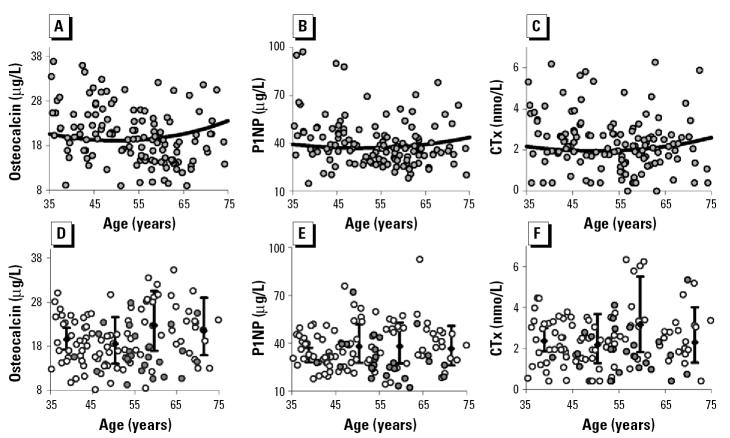
Background levels of the markers of bone turnover in men (A–C) and women (D–F). The lines represent the estimates from the robust regression models described in the text. In A–C, curvature lines and p-values represent the estimates of squared age variable. All p-values for associations between the linear age variable and all outcome variables were < 0.01. In D–F, open circles represent women who do not use estrogen, and shaded circles, women who use estrogen. Error bars are 95% confidence intervals of age groups. p-Values are given for the of 55–65-year age group compared with the < 45-year age group and for the estrogen users compared with nonusers (estro): (A) p = 0.06; (B) p = 0.13; (C) p = 0.03; (D) p = 0.08 (55–65 years), p = 0.005 (estro); (E) p = 0.09 (55–65 years), p < 0.001 (estro); (F) p = 0.07 (55–65 years), p = 0.001 (estro).